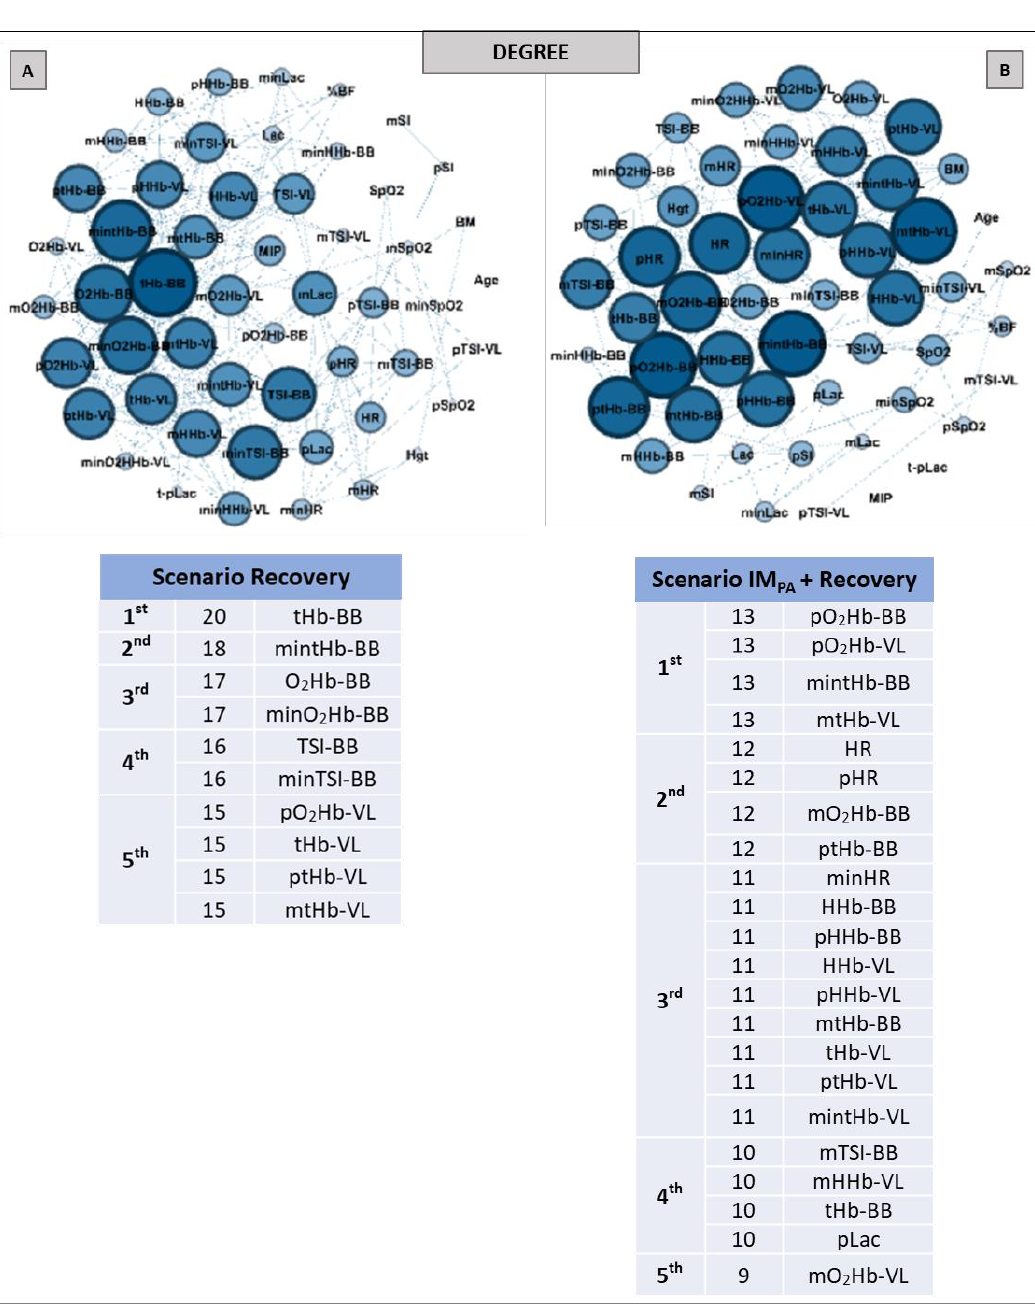
Figure 5. Graphs and top five node results obtained by complex network analysis using the Degree metric in two recovery scenarios: without inspiratory muscle pre-activation (Scenario Recovery, at Panel A ) and with inspiratory muscle pre-activation (Scenario IM PA + Recovery, at Panel B ). Graph visualizations were done using Gephi software (version 0.9.2, Paris, France). Legend: AO30 = all-out 30 s, IM PA = inspiratory muscle pre-activation, Hgt = height, BM = body mass, %BF = percent body fat, MIP = maximal inspiratory pressure, SI = global strength index of inspiratory muscles, Lac = blood lactate, HR = heart rate, SpO 2 = arterial oxygen saturation, O 2 Hb = oxyhemoglobin relative concentration, HHb = deoxyhemoglobin relative concentration, tHb = total hemoglobin, TSI = tissue saturation index. Abbreviations accompanied by p , m and min represent peak, mean and minimum values, respectively. Abbreviations accompanied by BB and VL represent the results in the biceps brachii and vastus lateralis,